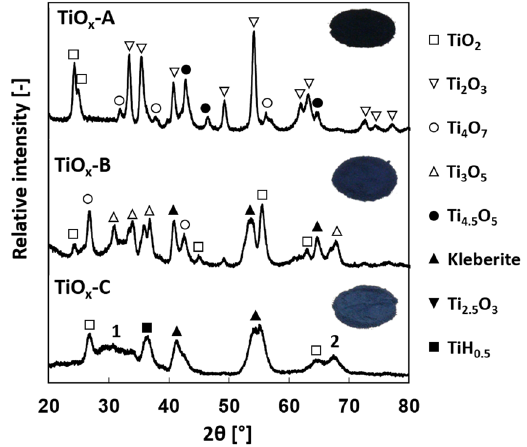
Figure 3. XRD spectra and the main peaks assignment of TiO x -A, TiO x -B, and TiO x -C. TiO x -A shows the greatest extent of reduction, indicated by the domination of the Ti 2 O 3 phase. The broad peak indicated by 1 is assigned to Ti 3 O 5 , Ti 4 O 7 , Ti 8 O 15 , and TiO 2 while 2 is assigned to Ti 3 O 5 and TiO 2 . Samples with a greater extent of reduction tend to have darker colors. A complete list of the identified species is provided in the supporting